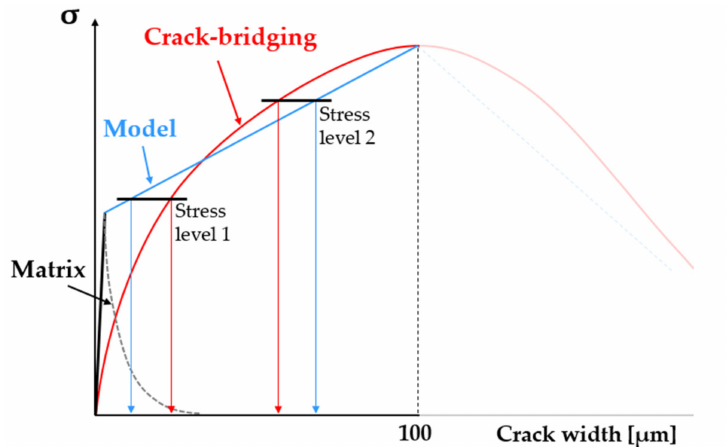
Figure 13. Difference between the numerical constitutive law (blue) and real crack-bridging relation- ship (red) causing a discrepancy between the average crack widths of the model and experimental SHCC